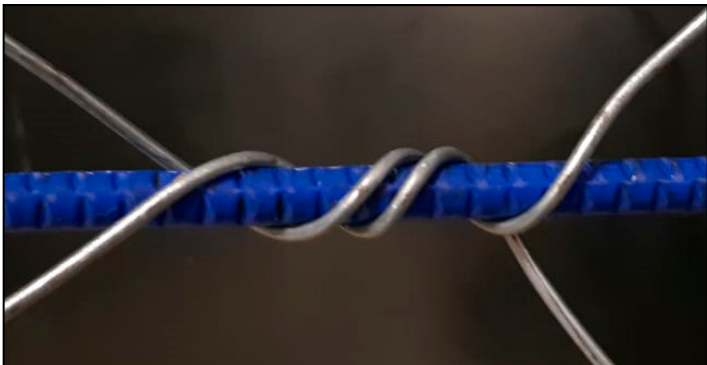
Figure 1. Detail of OF cable woven into the wire mesh: the cable is directly inserted into double-twisted sections during the weaving process.